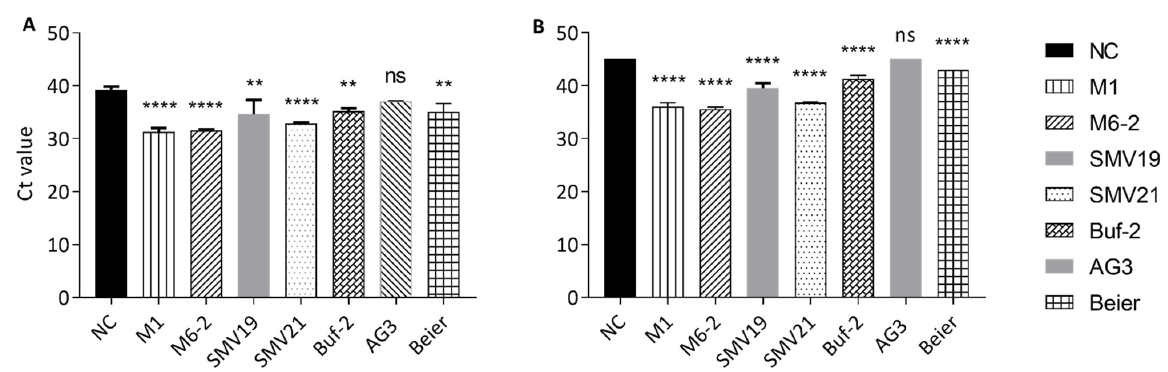
Figure 3. Aptamer mediated dot-blot using selected aptamers and five different genotypes of VLPs. Dot-blot with M1, M6-2, SMV19, SMV21, Buf-2, AG3, and Beier are depicted in ( A – G ), respectively. The dot-blot negative control (NC), omitting an aptamer binding step, showed no spots on the membrane ( H ). The concentration of the different VLP solutions applied to the nitrocellulose membrane (0–1500 nM) is indicated on each row’s left side. The different NoV genotypes used are indicated by the abbreviations GI.1, GI.7, GII.3, and GII.4 Sydney (Syd.) and New Orleans (Nola).